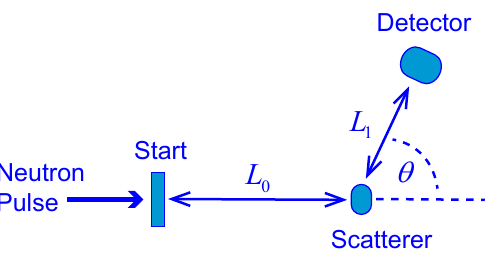
Figure A1. Scheme of a time-of-flight neutron scattering setup. (Taken from [11], with permission of Quanta